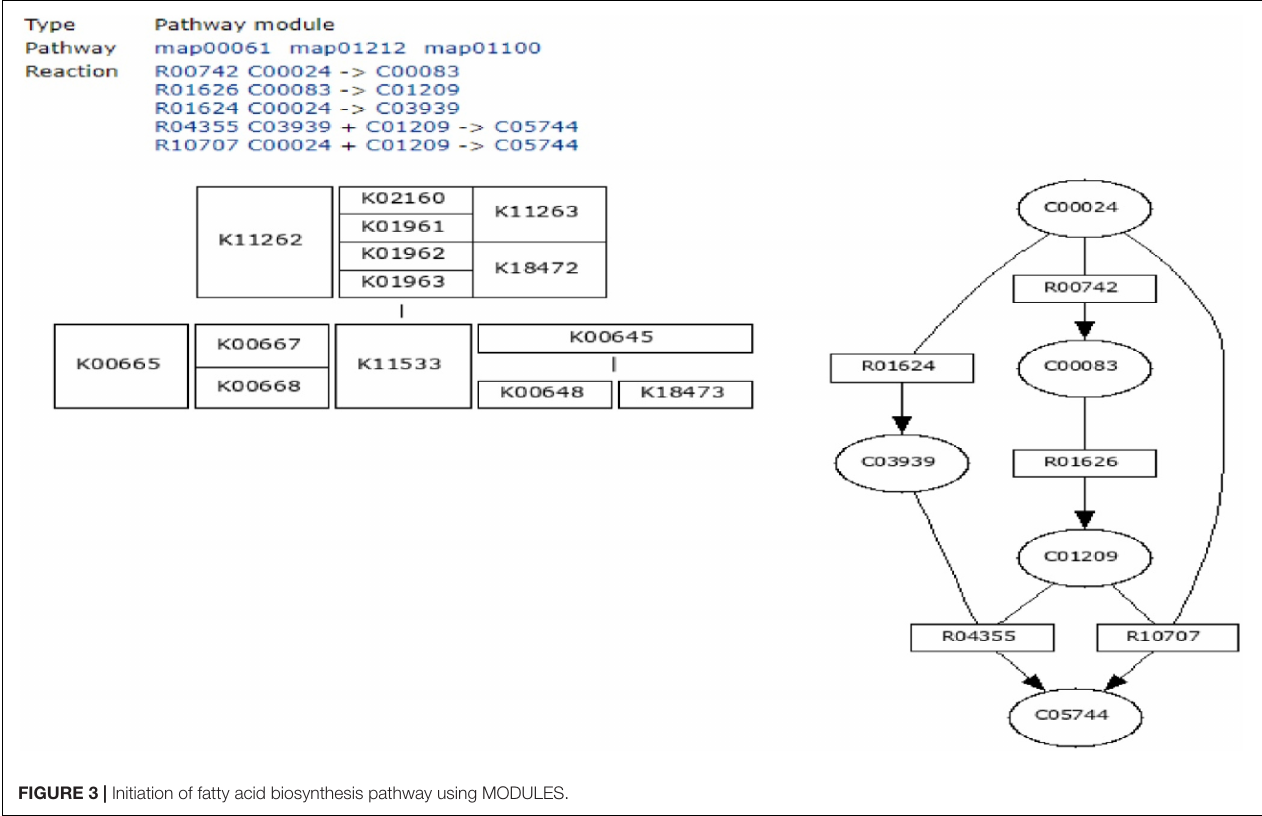
FIGURE 3 | Initiation of fatty acid biosynthesis pathway using MODULES.